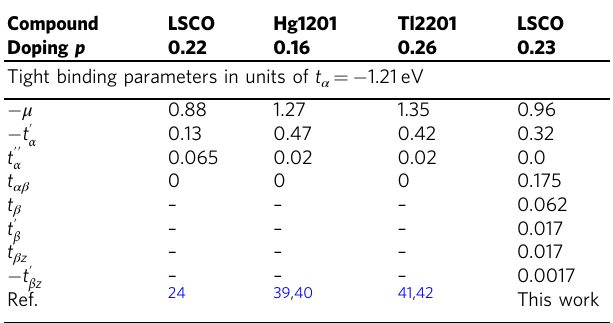
Tl2201 LSCO 0.26 0.23